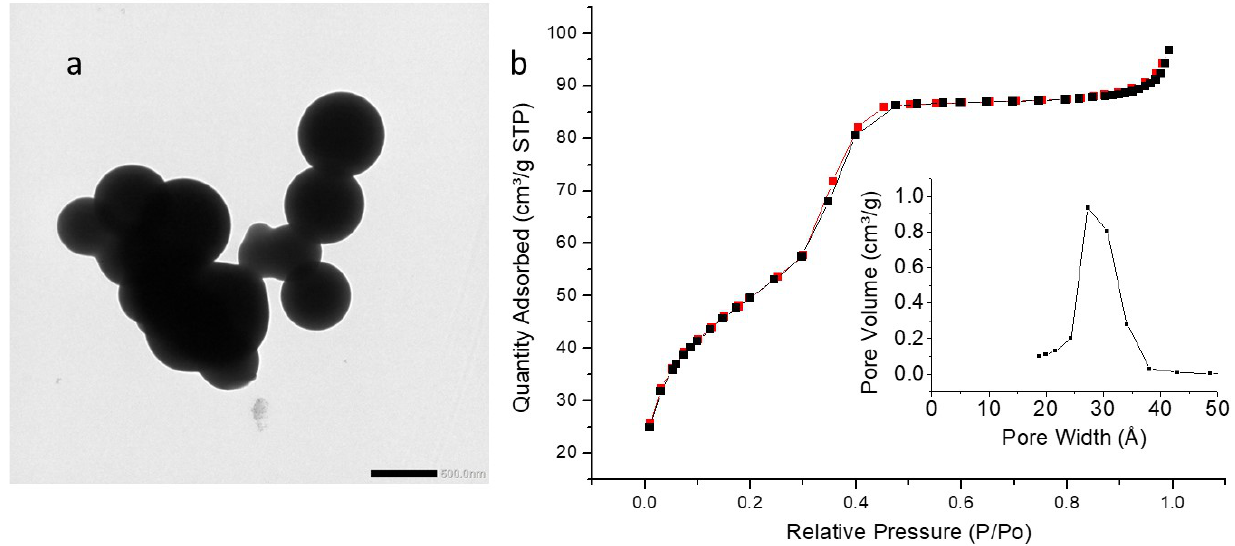
Figure 13. ( a ) TEM image of EtbiPyPMO 6 scale bar 500 nm. ( b ) Nitrogen adsorption–desorption at 77 K. Insert BJH desorption (dV/dlog(w)) Pore Volume.